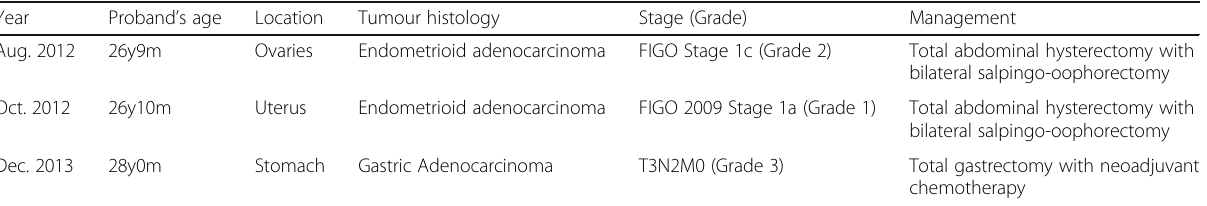
Table 2 Cancer tumour tissue histology and the management of malignancies in the proband